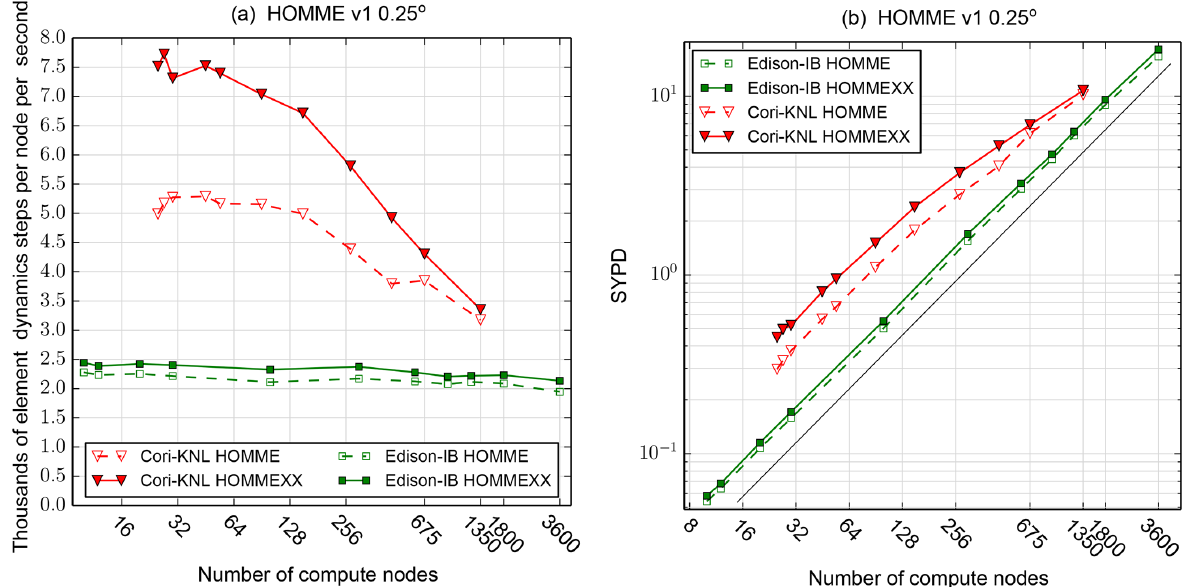
Figure 10. As Fig. 9, but with parameters chosen according to E3SM version 1 0 . 25 ◦ model. In the version 1 model, (i) n e = 120; (ii) the number of hyperviscosity sub-cycles is four instead of three; and (iii) there are two horizontal steps per one vertical remapping step instead of 3. Because of (iii), in (a) we plot average time per horizontal step plus half a vertical remapping step. To compare Figs. 10 and 9, divide the y axis value by